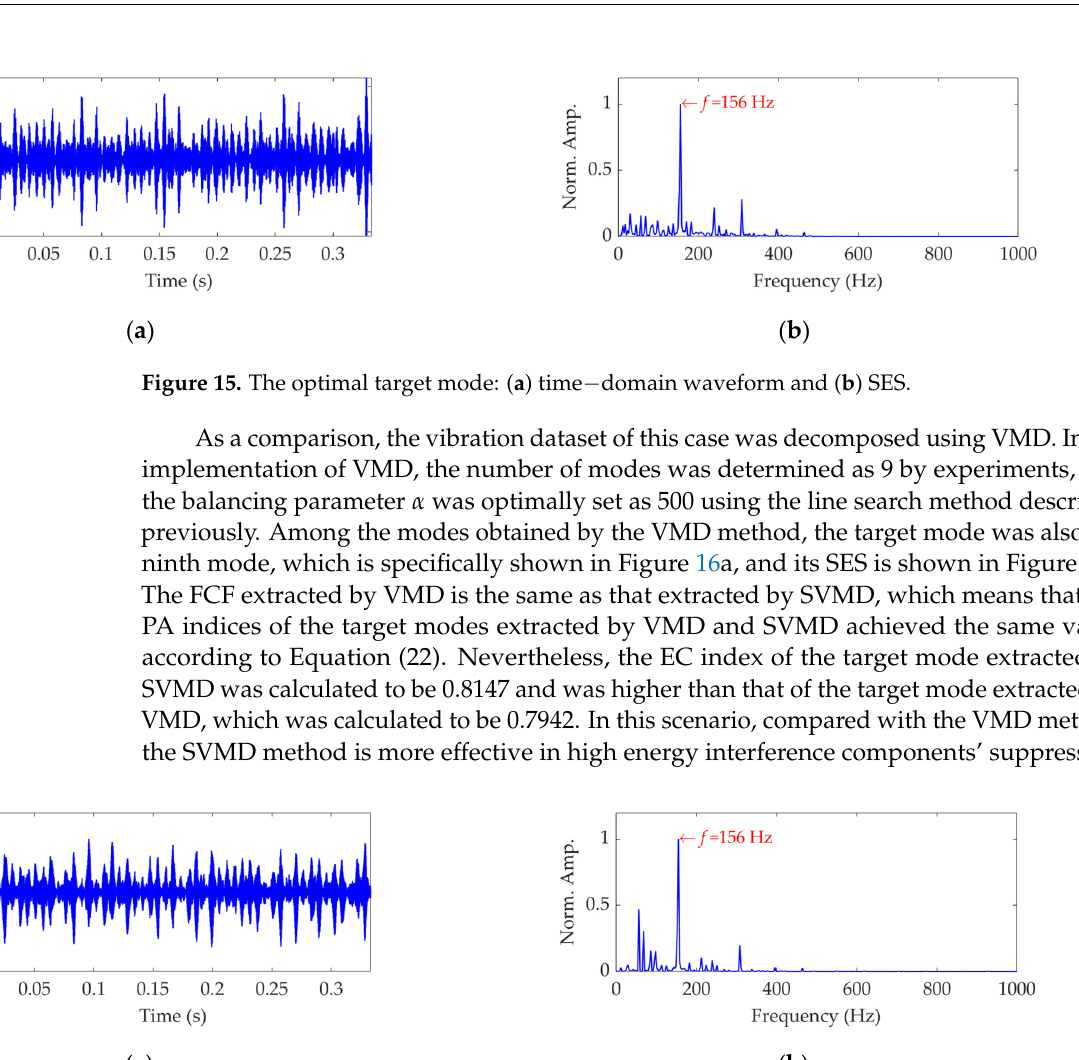
Figure 14. The EP index of each mode.